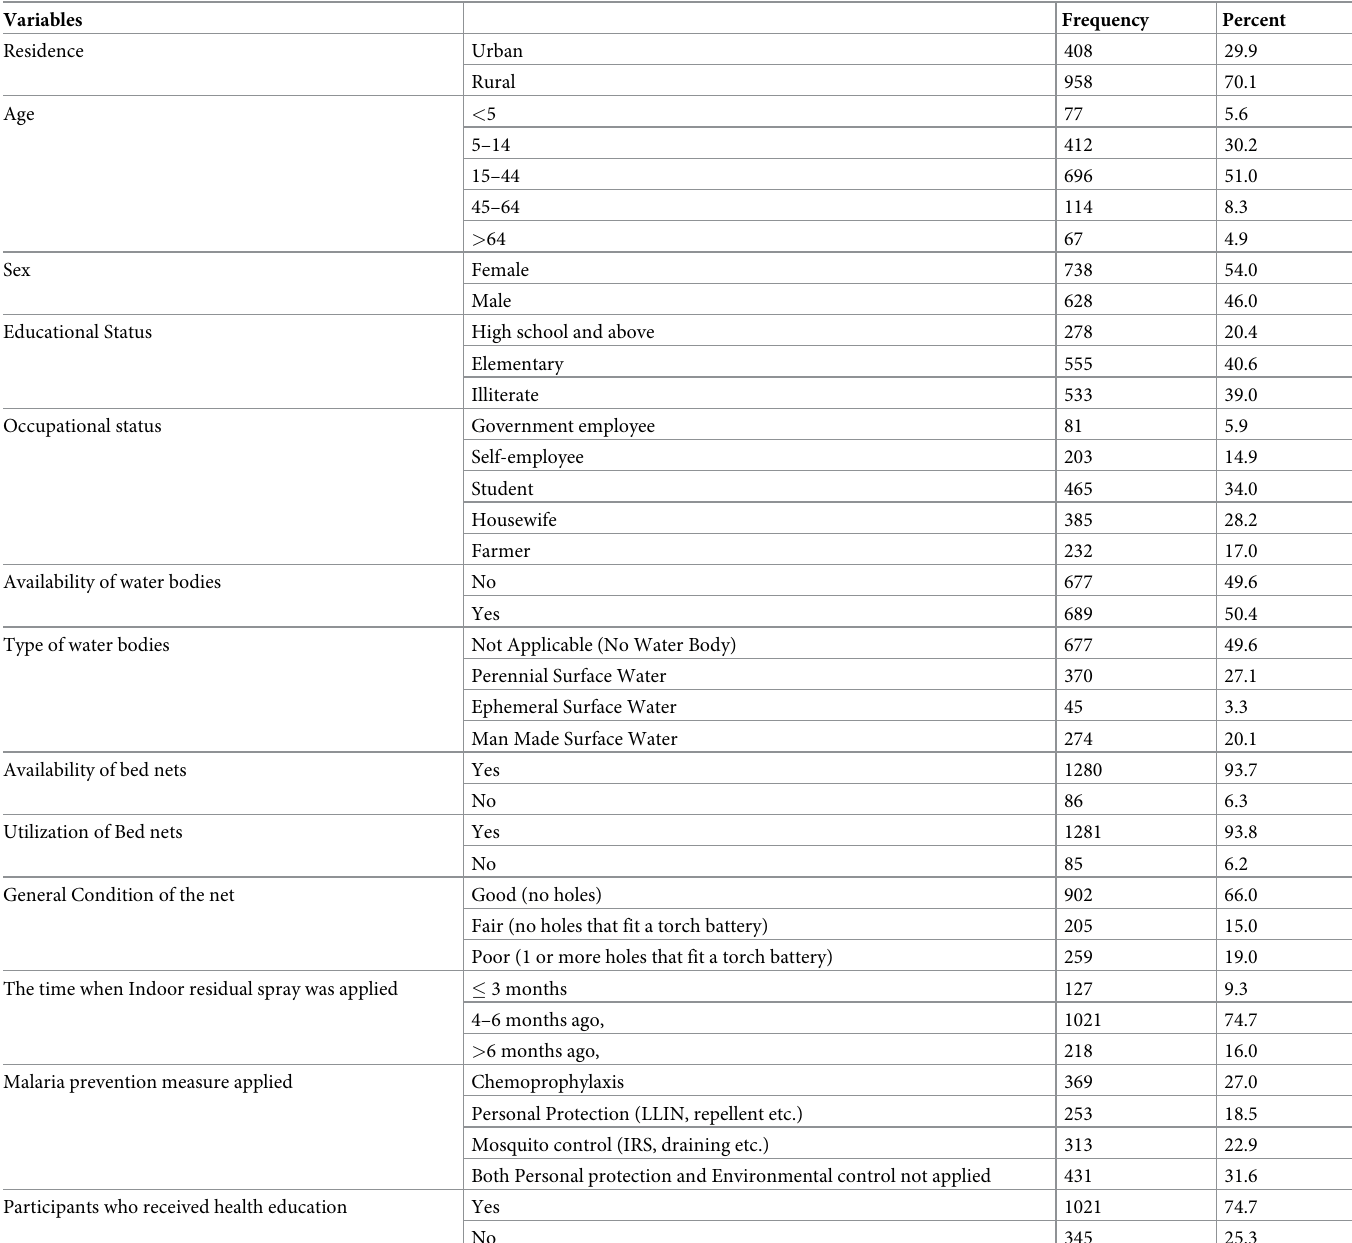
Table 1. Socio-demographic characteristics of sampled